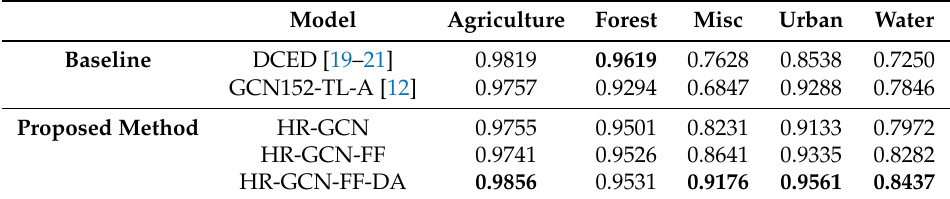
Table 6. Effects on the testing set of Landsat-8w5c data set among each class with our proposed procedures in terms of AverageAccuracy